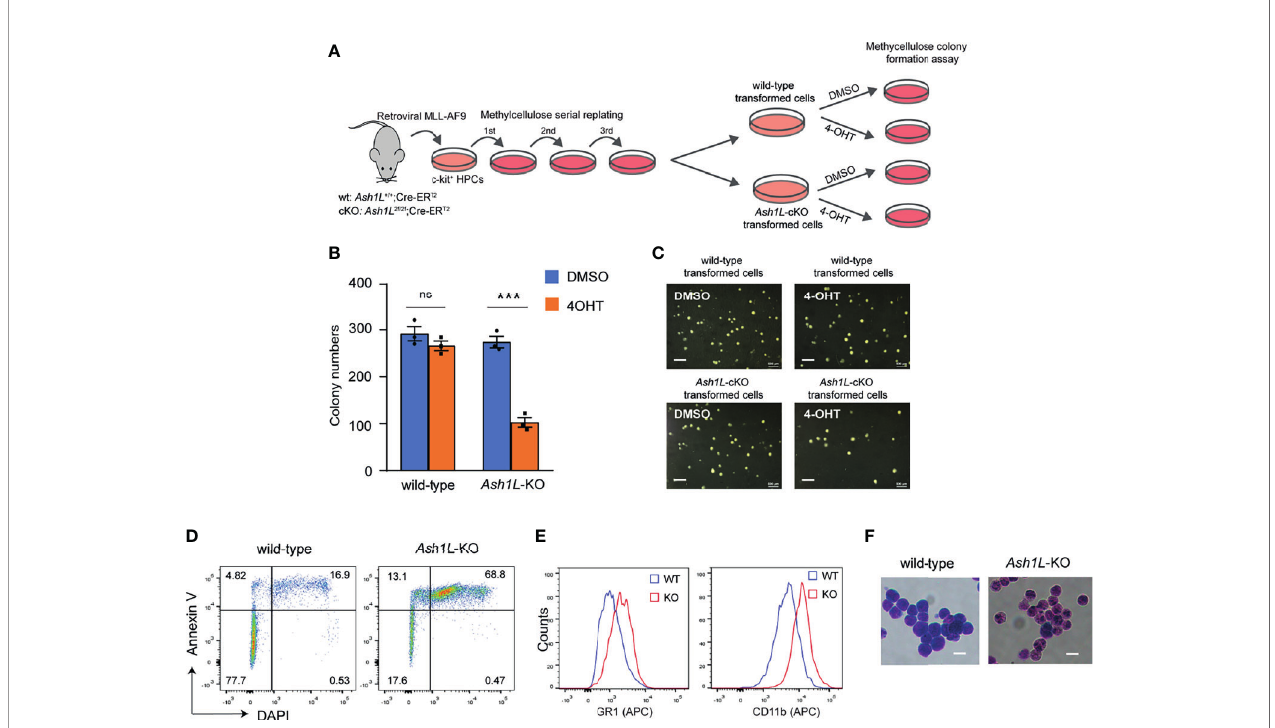
FIGURE 2 | ASH1L is required for the maintenance of MLL-AF9-induced leukemic cells in vitro . (A) Schematic experimental procedure. (B) Methylcellulose colony formation assays showing the colony numbers. The error bars represent mean ± SEM, n = 3 per group. *** P < 0.001; ns, not signi fi cant. (C) Photos showing the representative colony formation on methylcellulose plates for each group. Bar = 0.5 mm. (D) Representative FACS results showing the Annexin V+ and DAPI+ populations of wild-type and Ash1L -KO MLL-AF9-transformed cells. (E) Representative FACS results showing the GR-1 and CD11b expression of wild-type and Ash1L -KO MLL-AF9-transformed cells. (F) Photos showing the Wright-Giemsa staining of wild-type and Ash1L -KO MLL-AF9-transformed cells. Bar = 10